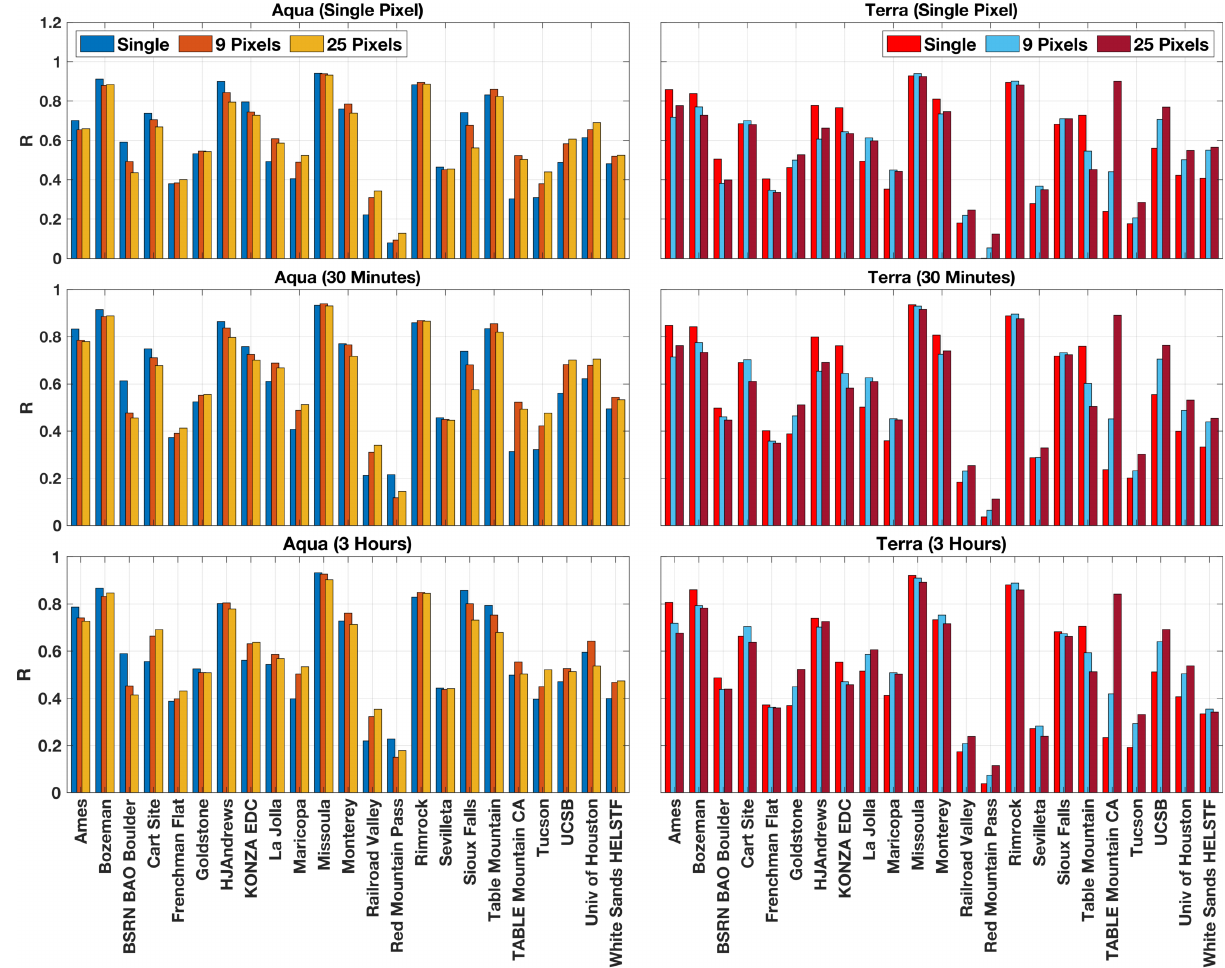
Figure 5. Pearson correlation coefficient between MODIS DB AOD (Aqua and Terra) and AERONET AOD over 23 stations at different combinations of temporal and spatial averaging domains. The actual of AODs are available in the data at that https://doi.org/10.17632/9v6pwjzxg6.1 (accessed on 11 June